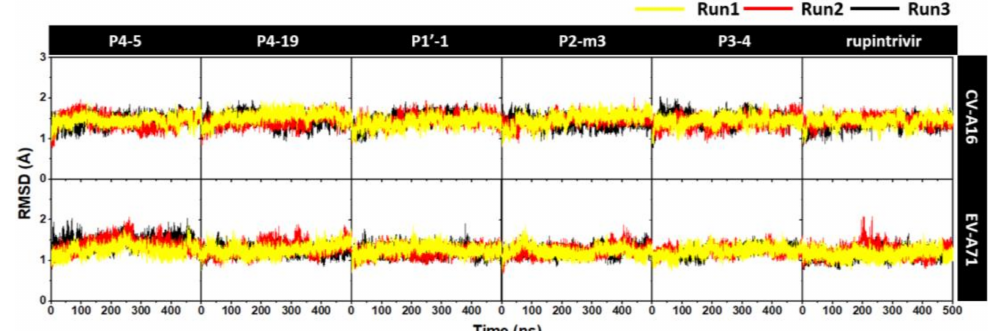
Figure 3. All-atom RMSD plots for the CV-A16 and EV-A71 3Cpro in complex with five focused analogs P4-5, P4-19, P1 (cid:48) -1, P2-m3, and P3-4, as well as rupintrivir, plotted along the 500 ns from the three independent simulations (Run1, Run2, and Run3).